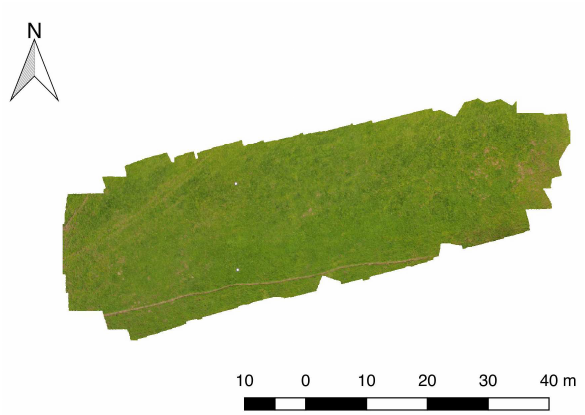
Figure 4. Orthomosaic generated from the aerial survey over the grassland area selected.